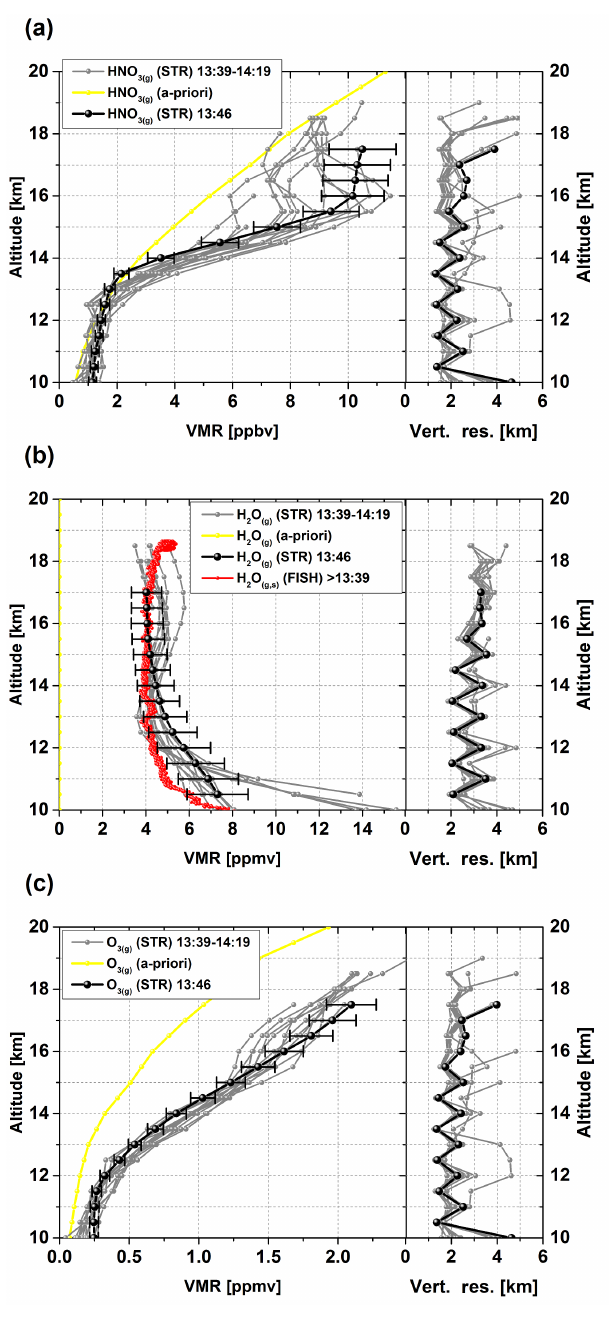
Figure A1. Vertical cross sections of (a) H 2 O ( g ) and (b) O 3 along flight track retrieved from the MIPAS-STR observations. Vertical flight profile (black line) and turns between different flight legs (grey hatched areas). Data points are filtered for a vertical resolu- tion better than 5km.